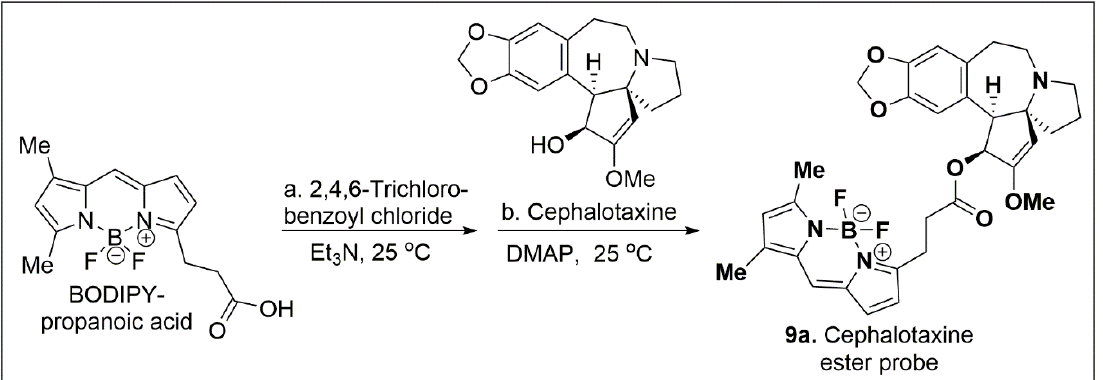
Figure 6. Representative images of protein synthesis inhibition EZClick™ assay using MDA-MB-231 cellular model. Cells were treated with compounds for 1.5 h prior to click reaction followed by staining. A. Vehicle (DMSO). B. Positive control CHX (1 μ M). C. Compound 9 (5 μ M). D. Compound 10 (10 μ M). E. Compound 12 (10 μ M). F. Compound 13 (10 μ M). G. Relative quantification. Scale